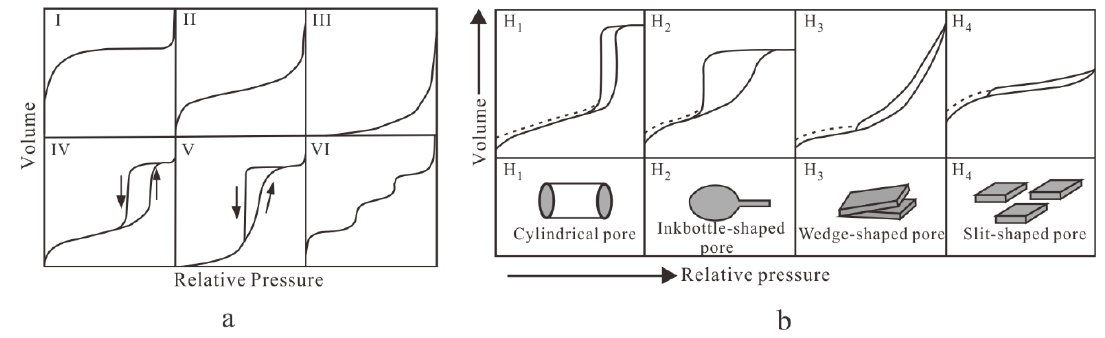
Figure 5. Types of adsorption isotherms ( a ), hysteresis loops and corresponding pore types ( b ) (base map cited from Sing, K. S. W. et al., 1985) [53].